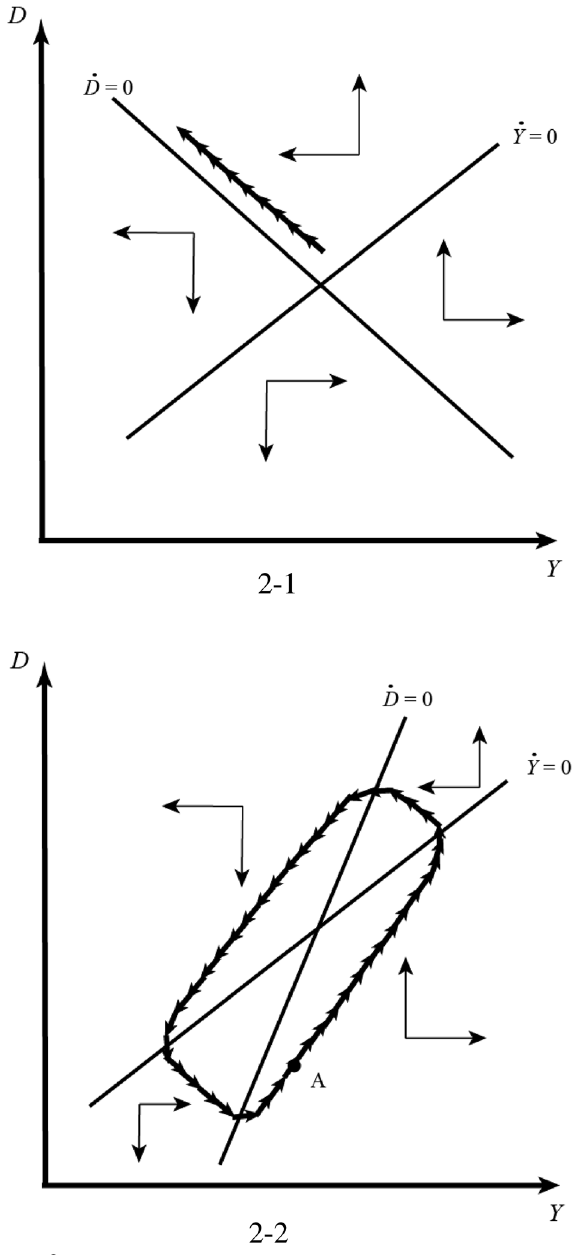
Fig. 2 Dynamic system S